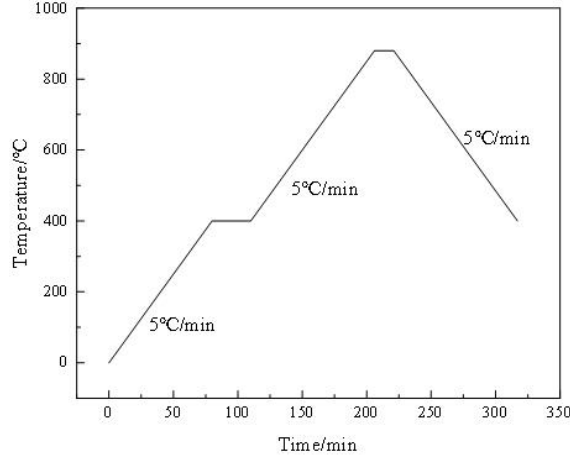
Figure 4. Thermal cycling curve of brazing.